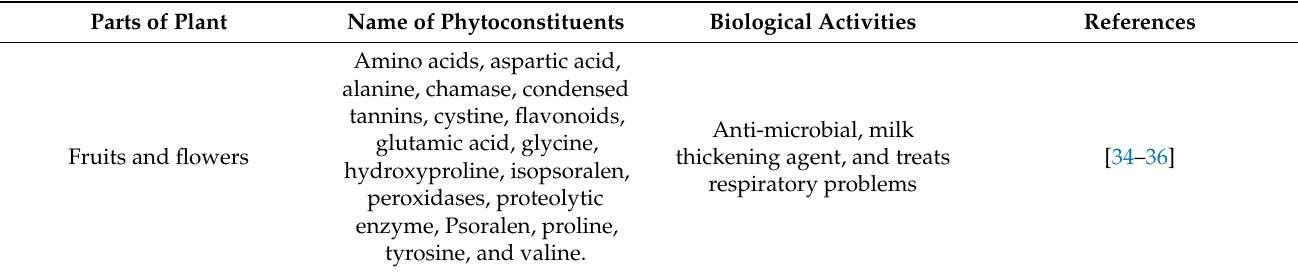
Table 4. Different biological compounds present in fruits and flowers, and their